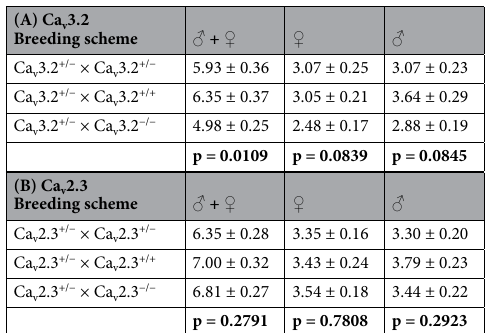
Table 2. Litter sizes in Ca v 3.2 and Ca v 2.3 null mutant breeding. (A) Litter sizes for Ca v 3.2 +/− × Ca v 3.2 +/− , Ca